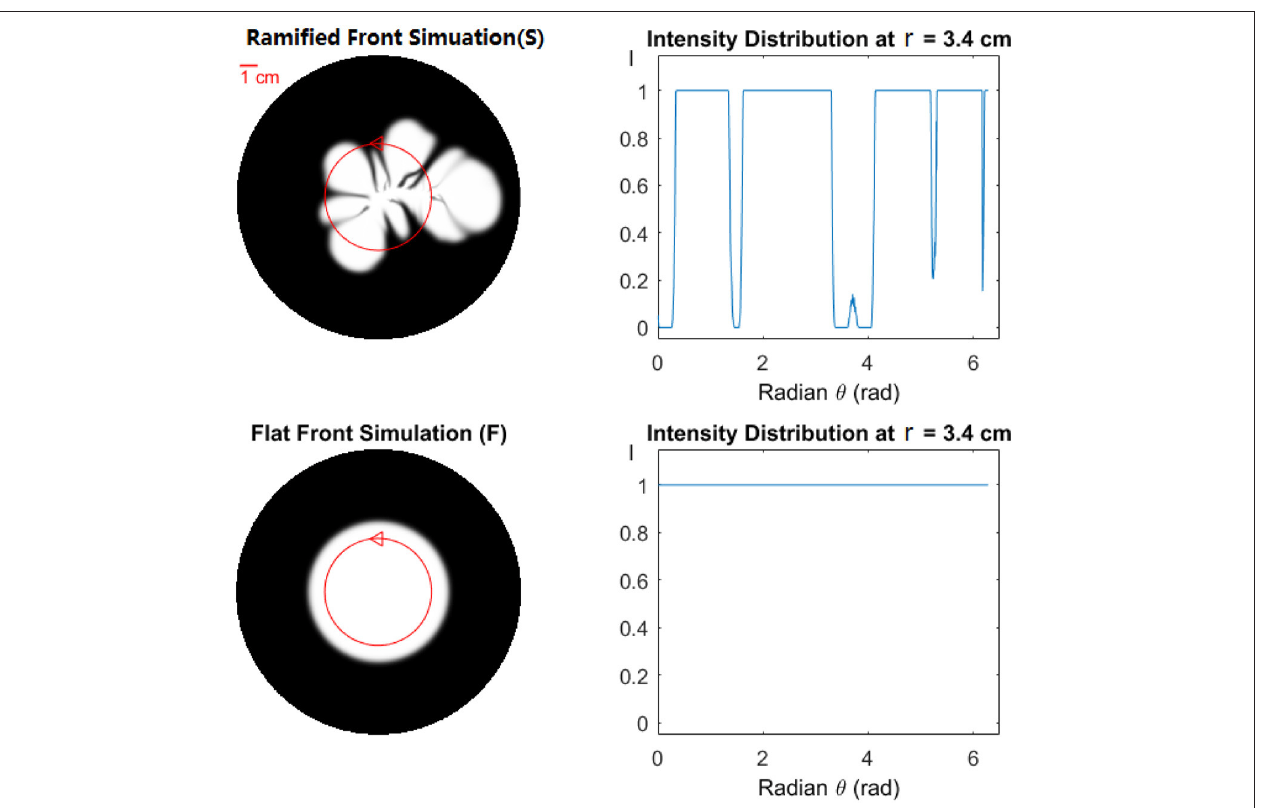
FIGURE 7 | Effect of front geometry. (Top) Ramified Front Simulation (S) shows the result of simulation with the ramified front (dissolution pattern). (Bottom) Flat Front Simulation (F). The normalized intensity distribution at r 3.4 cm, marked with a red circle on the left, is shown as a function of angle on the right. The distribution = begins at the marked triangle, and continues